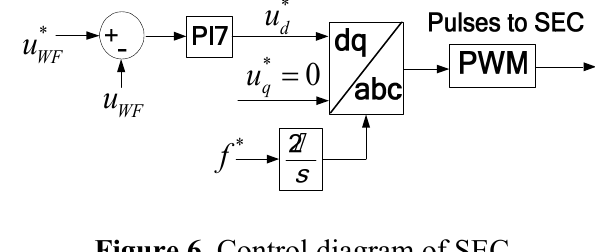
Figure 6. Control diagram of SEC.